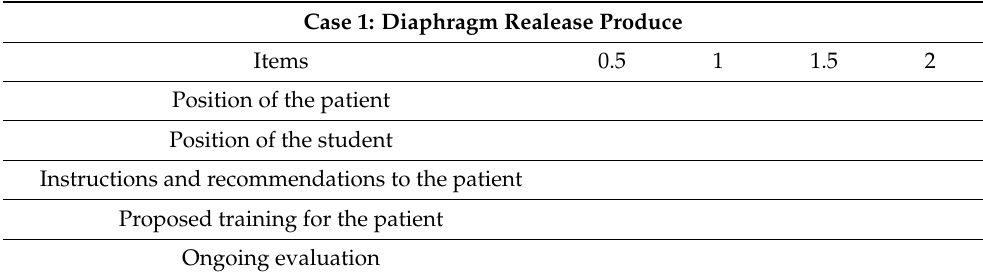
Table A1. Evaluation rubric used for case 1 in traditional